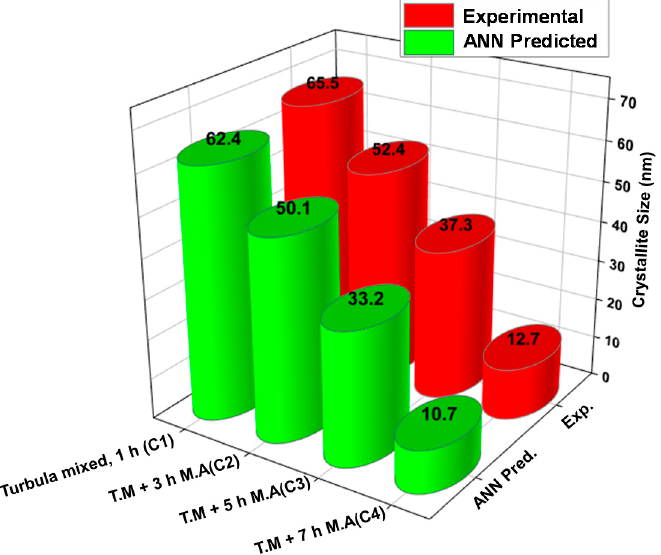
Figure 16. Variation in crystallite size for the experimental and ANN-predicted values as a function of milling time.